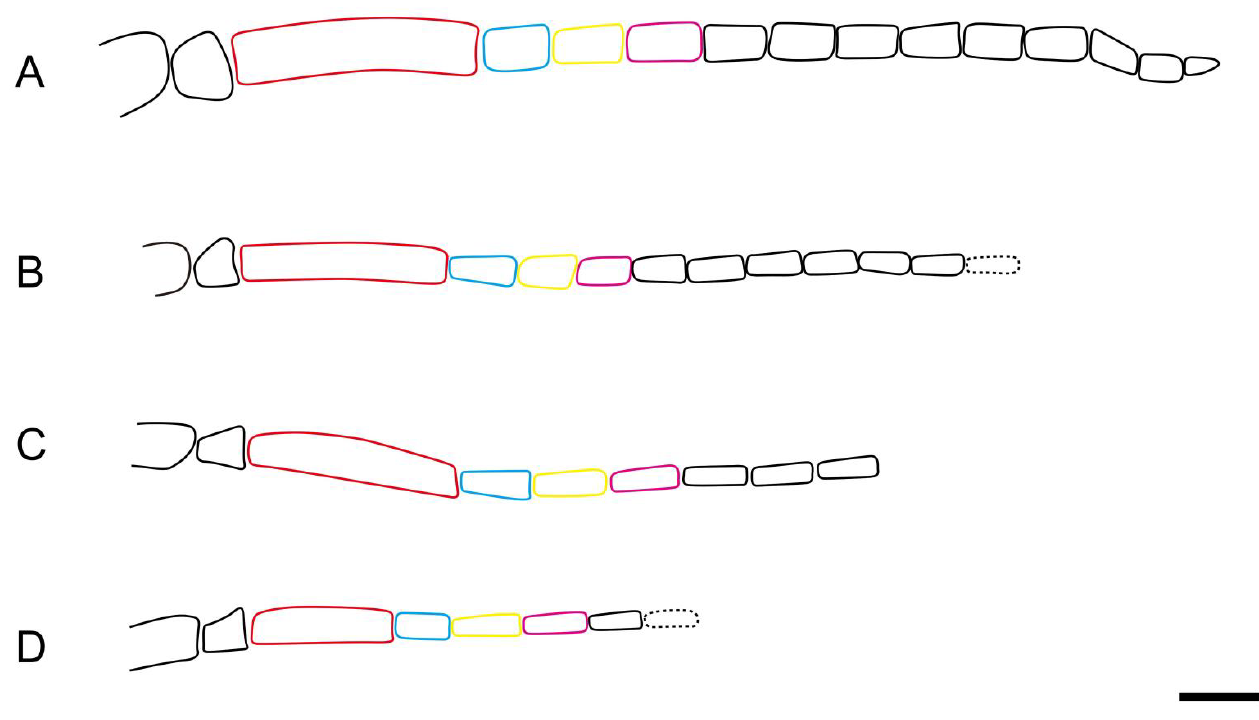
Figure 5. Line drawings of different types of antennae in Scabolyda . ( A ) Scabolyda latusa sp. nov. ( B ) Scabolyda orientalis Wang, Rasnitsyn, Shih and Ren, 2014. ( C ) Scabolyda tenuis sp. nov. ( D ) Scabolyda incompleta Wang, Rasnitsyn, Shih and Ren, 2014. Notes: flagellomeres in red, blue, yellow, and purple colors = the first, second, third, and fourth flagellomere, respectively. Scale bars: 0.5 mm. Table 1. The ratio of main flagellomeres in Scabolyda